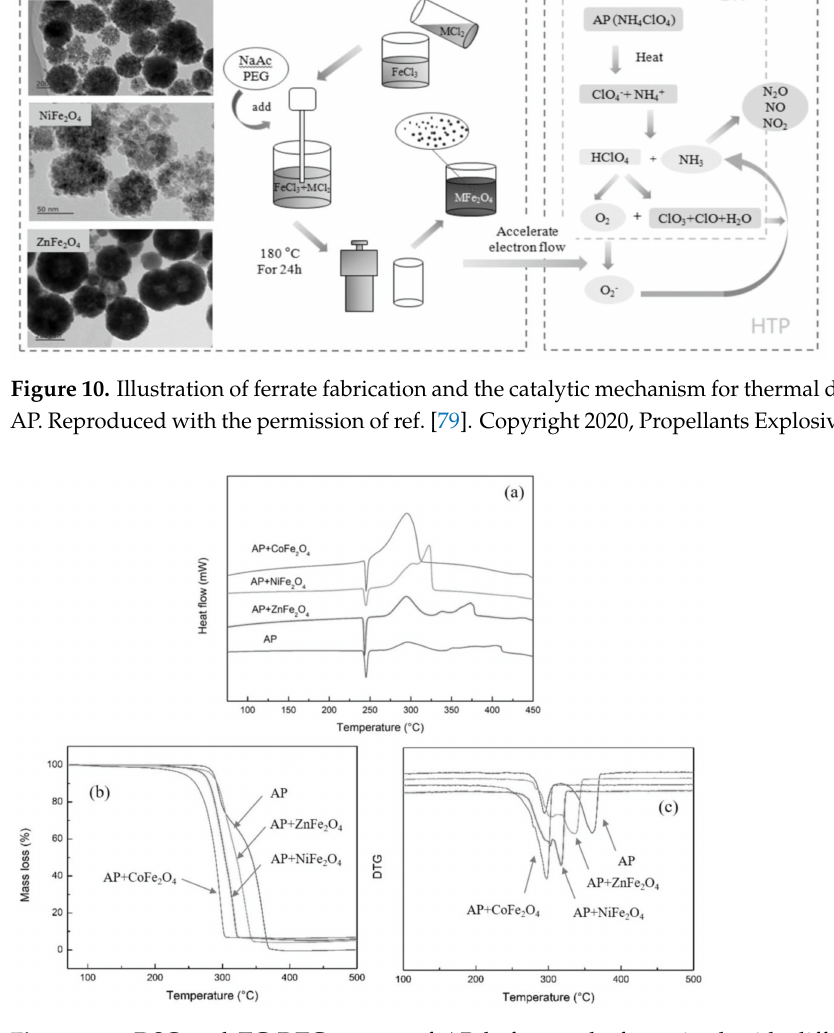
Figure 11. DSC and TG-DTG curves of AP before and after mixed with different ferrates at 10 ◦ C min − 1 ( a ) DSC curves, ( b ) TG curves, ( c ) DTG curves. ( a – c ) Reproduced with the permission of ref. [79]. Copyright 2020, Propellants Explosives